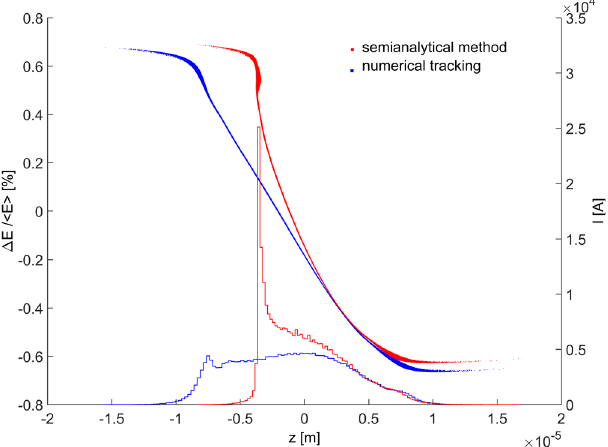
FIG. 4. Longitudinal phase space and current profile of the electron beam during the forward optimization of the compres- sion scheme. The use of the semianalytic method already enables an overcompressed distribution with a large energy chirp (red). The numerical optimization has been applied to the output of the semianalytic method to fine-tune the current profile